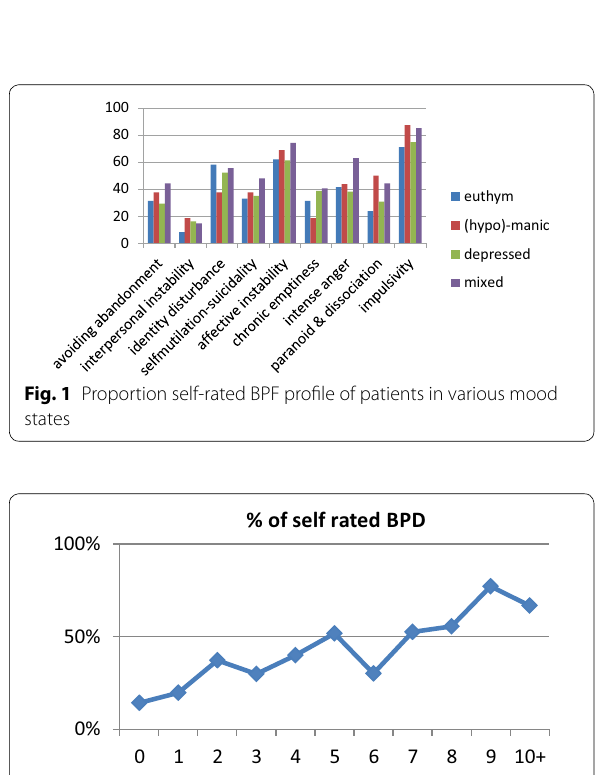
Fig. 2 Proportion of bipolar patients with in relationship to prospective full-duration DSM-IV episode